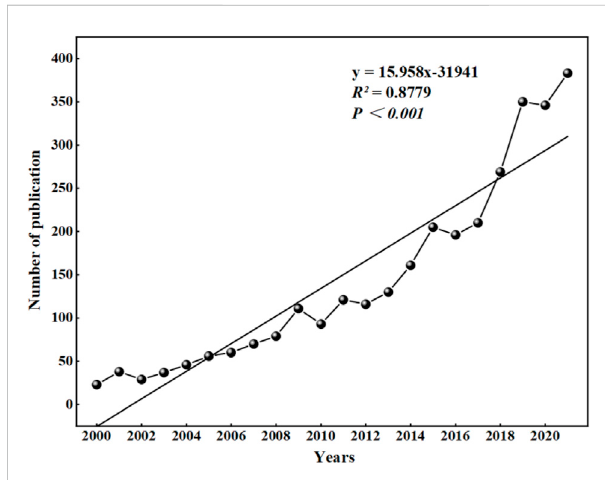
FIGURE 1 Trends in the number of articles published in the fi eld of alpine meadow research.